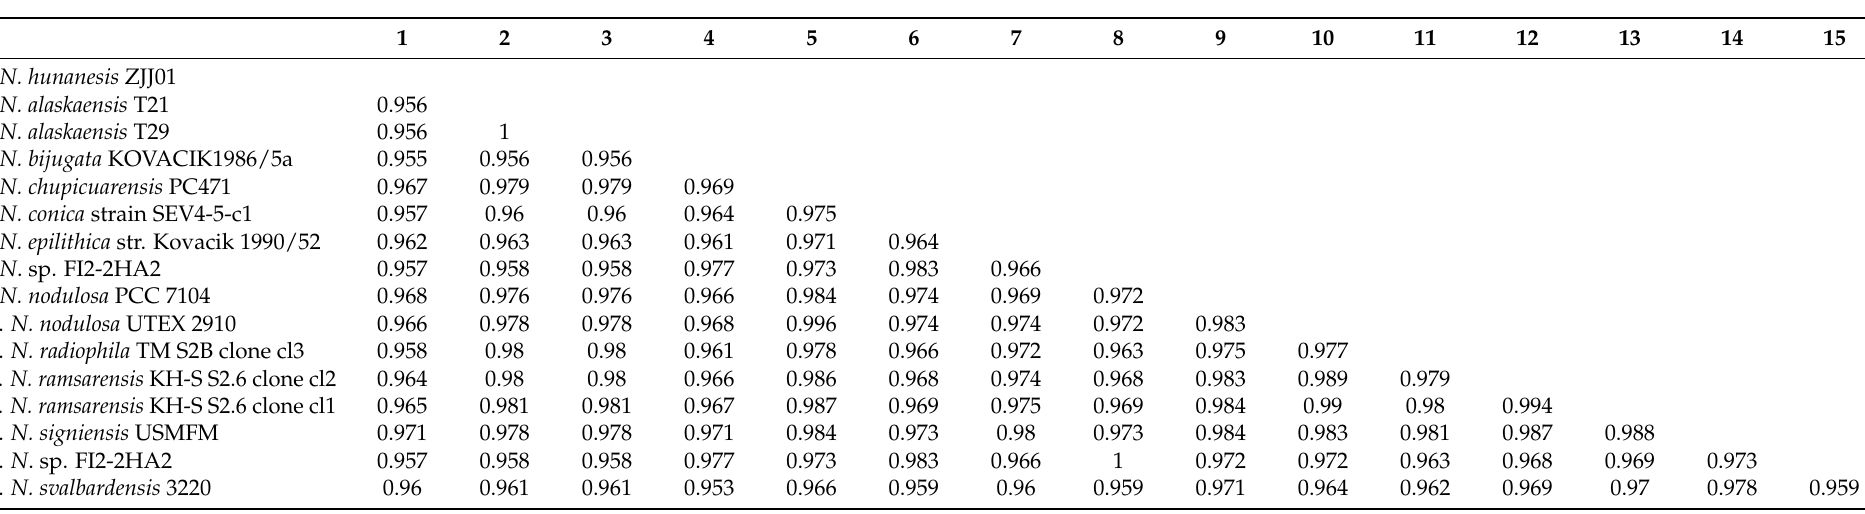
Table 1. Sequence similarity comparison of the 16S rRNA gene between the Nodosilinea hunanesis strain and its close species. Similarity = [1 − (p-distance)] ×